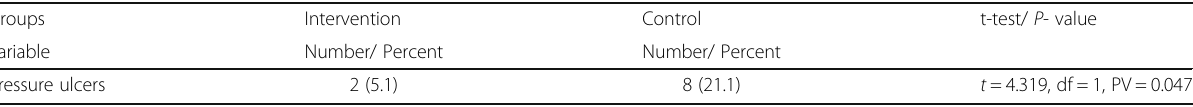
Table 5 Frequency of pressure ulcers in two groups Groups